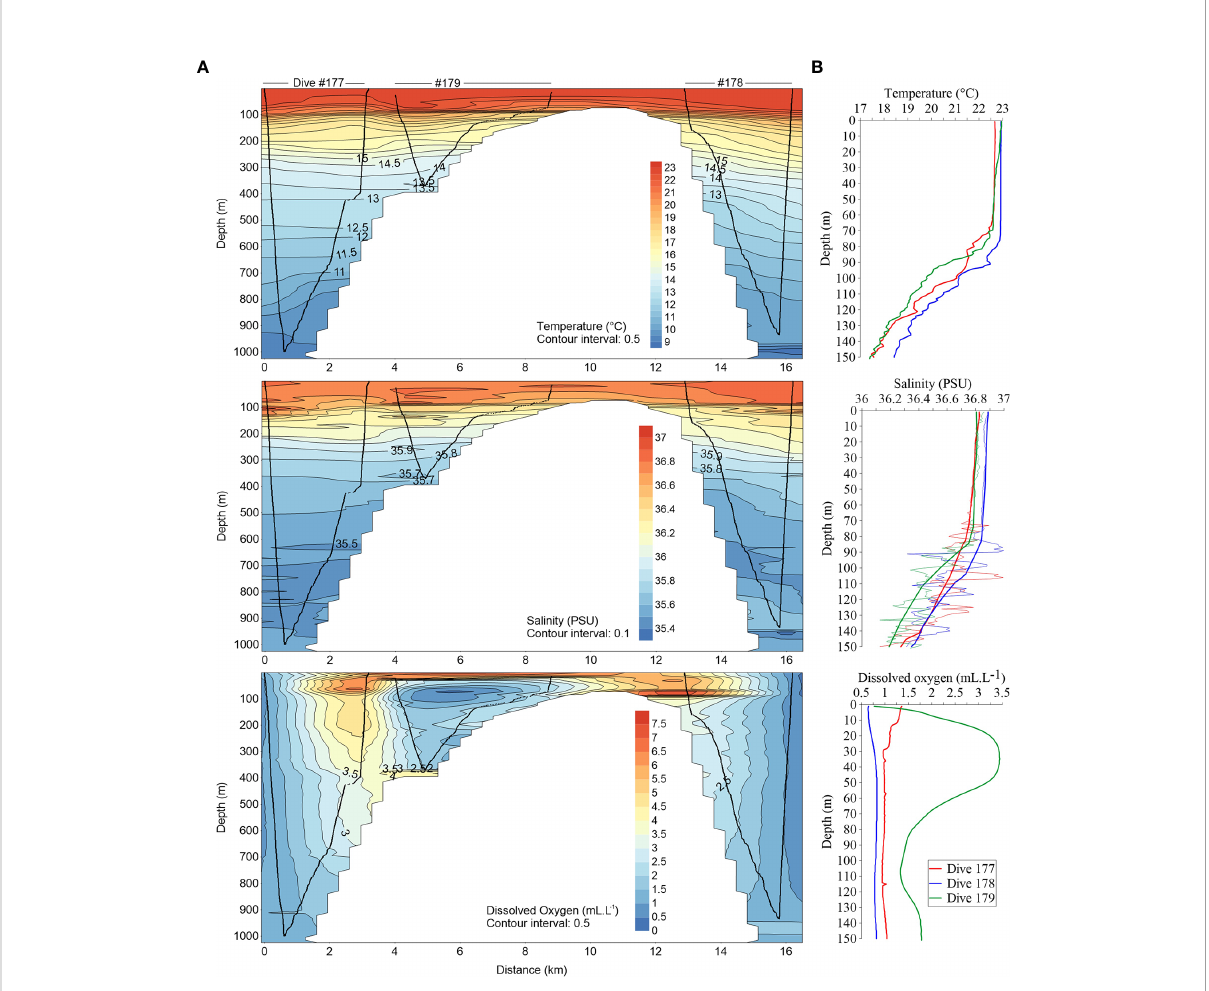
FIGURE 2 (A) Cross-sectional distribution of water temperature, salinity and dissolved oxygen concentration from the along-ridge water column pro fi ling dives (western to eastern fl ank) with the sub-mounted CTD (downcast, along seabed and upcast); (B) Downcast vertical pro fi les of those parameters until 150 m depth. At salinity plot solid tick lines represent general trend and thin lines in situ